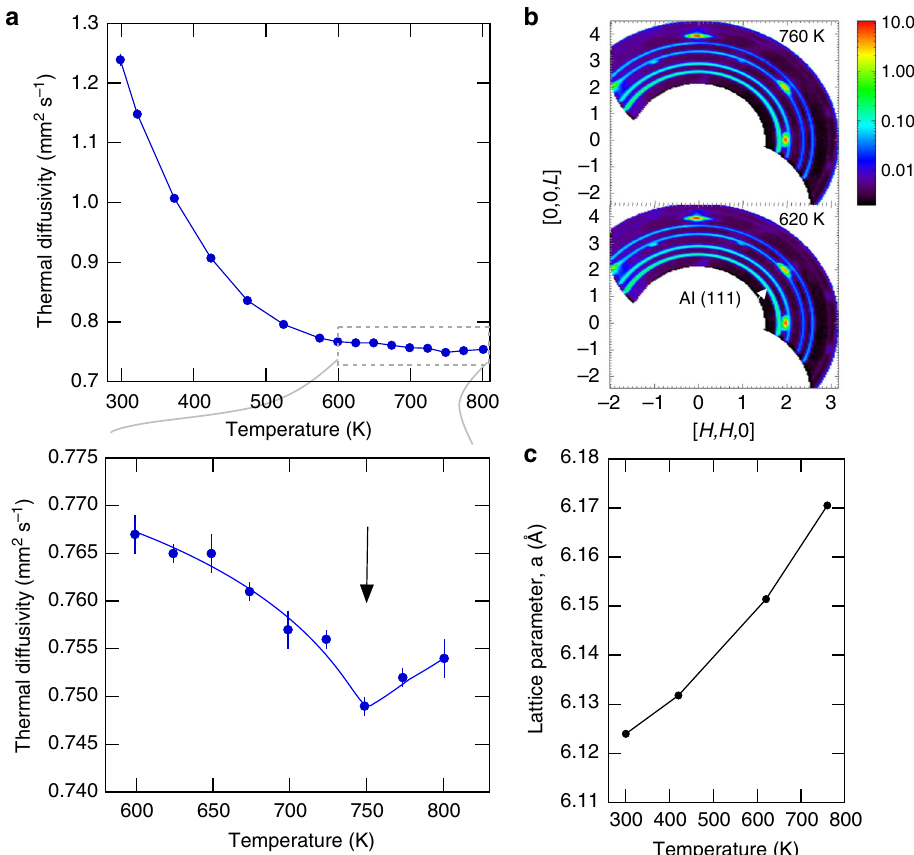
Fig. 5 Thermal diffusivity anomaly absent a structural transition. a Thermal diffusivity measured using laser fl ash method on a piece of the same crystal used in the neutron scattering measurements. Lower panel shows a closeup view of a small negative kink in the data near 750K (line is guide to the eye). b Single crystal diffraction pattern measured on the HYSPEC instrument above and below the temperature of the kink. The rings are aluminum powder rings from the crystal holder, which were used to calibrate the instrument when determining the PbSe lattice parameter. c Lattice parameter as a function of temperature determined by fi tting the single crystal diffraction peaks. The re fi ned lattice parameter of 6.124 ± 0.0005 Å at 300 K is in good agreement with the known value (the Al rings were used to calibrate the instrument assuming an Al lattice parameter of 4.046 Å at room